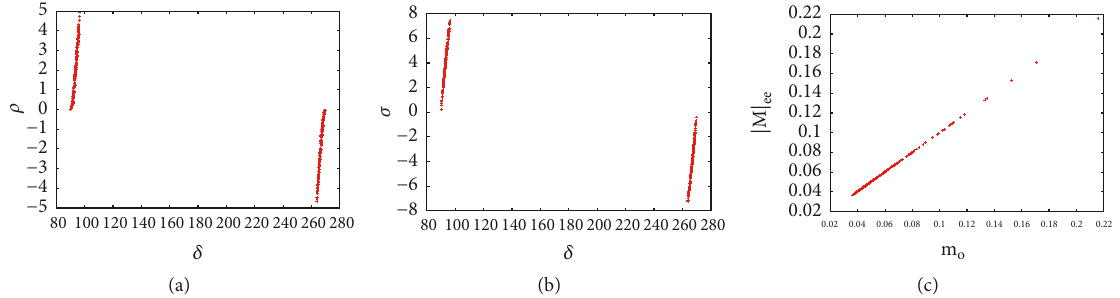
Figure 8: Correlation plots for texture 𝐷 7 (IS) for type X at 3 𝜎 CL. The symbols have their usual meaning. 𝛿,𝜌 , and 𝜎 are measured in degrees, while |𝑀| 𝑒𝑒 and 𝑚 0 are in eV